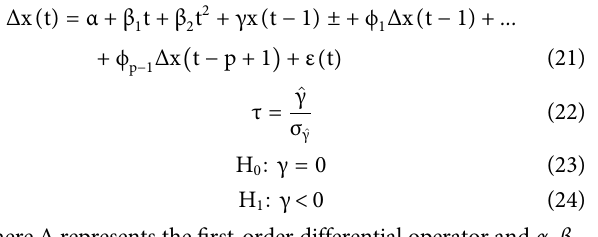
Frontiers in Earth Science |